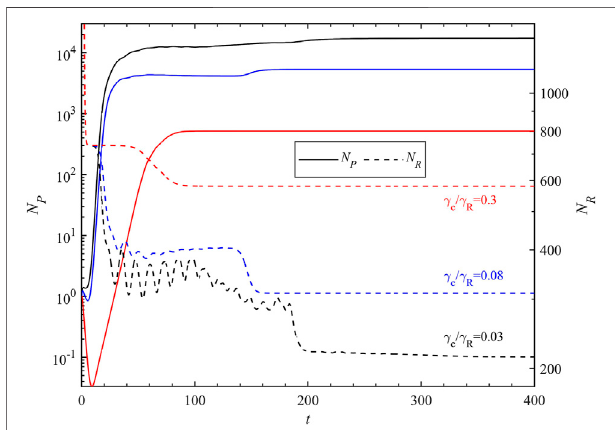
FIGURE 4 | (Color online) Evolutions of total number of polaritons N p (solid lines) and reservoir excitons N R (dash lines) with time t for the decay ratios c c / c R (cid:2) 0 . 03 , 0 . 08 , 0 . 3, corresponding to the cases of Figures 3B – D ,